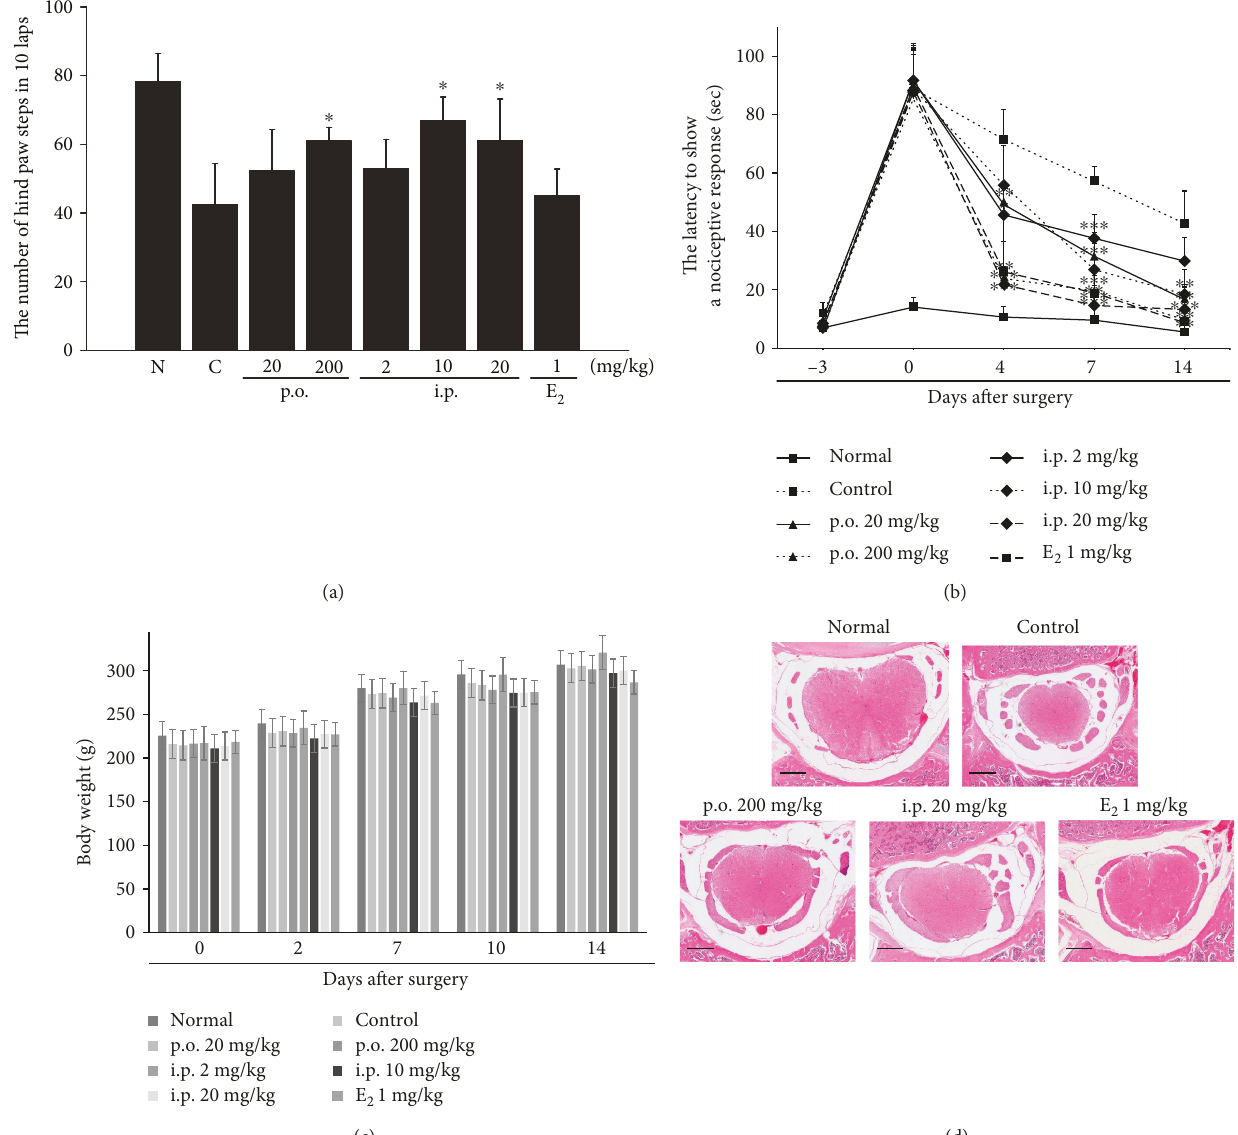
Figure 2: E ff ects of SHINBARO on locomotor and sensory functions in the LSS rat model. (a) The recovery of locomotor function measured by the running wheel system in the 7th day after LSS operation. (b) Time course of change in response times to a thermal stimulus using a hot plate. (c) Body weight change was monitored during the test period. The data are expressed as the mean ± SD ( n = 5 ). (d) Histopathological analysis of the spinal structure following administration of SHINBARO in the LSS rat model. The spinal cord (red) in the spinal canal (white) was stained with hematoxylin and eosin (H&E). Scale bar = 800 μ